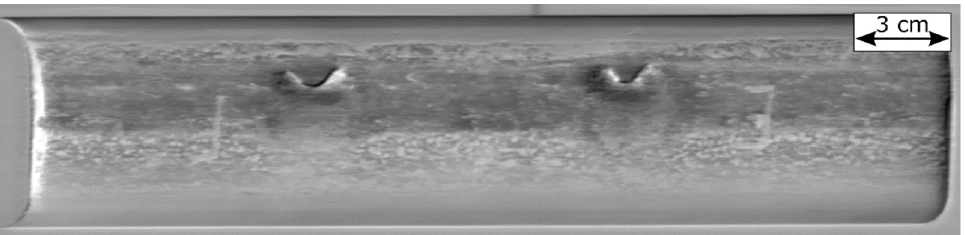
Figure 16. Measurement with µ-bolometer camera and increased frame rate (100 Hz) with a scanning speed of 50 mm/s.